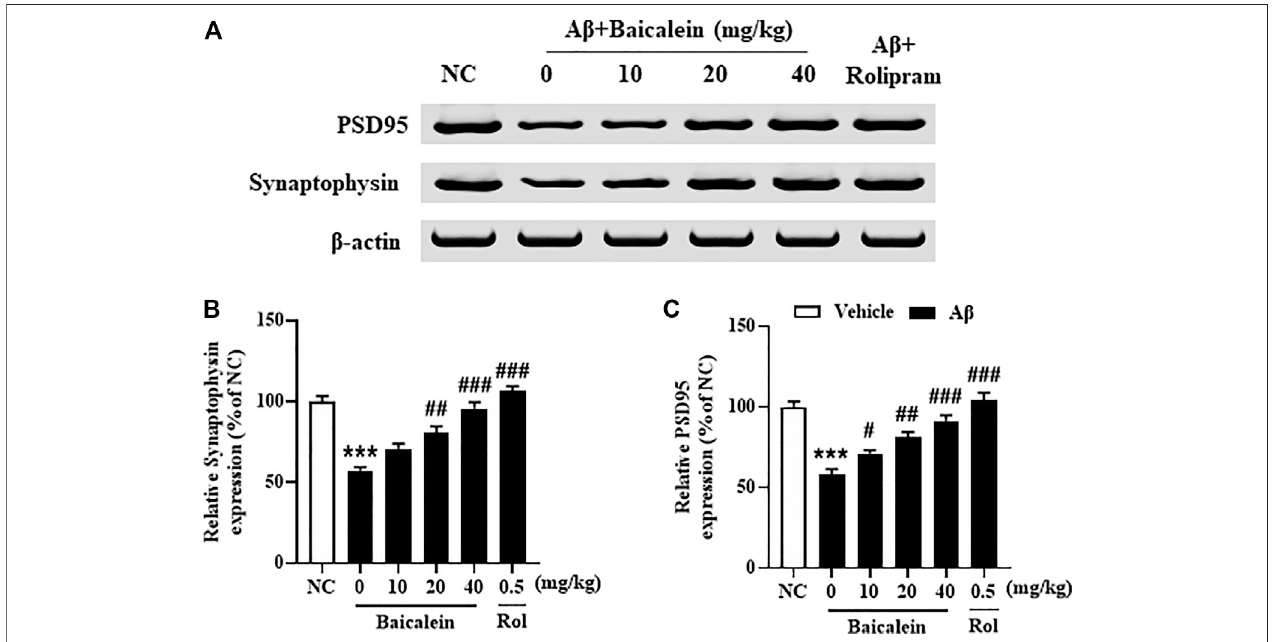
FIGURE6| BaicaleinrescuedtheexpressionofPSD95andsynaptophysininthehippocampusofA β -treatedmice.Allvalueswereexpressedasmean ± SEM( n (cid:2) 6). *** p < 0.001 vs. NC mice; # p < 0.05, ## p < 0.01, ## p < 0.001 vs. A β -treated mice.